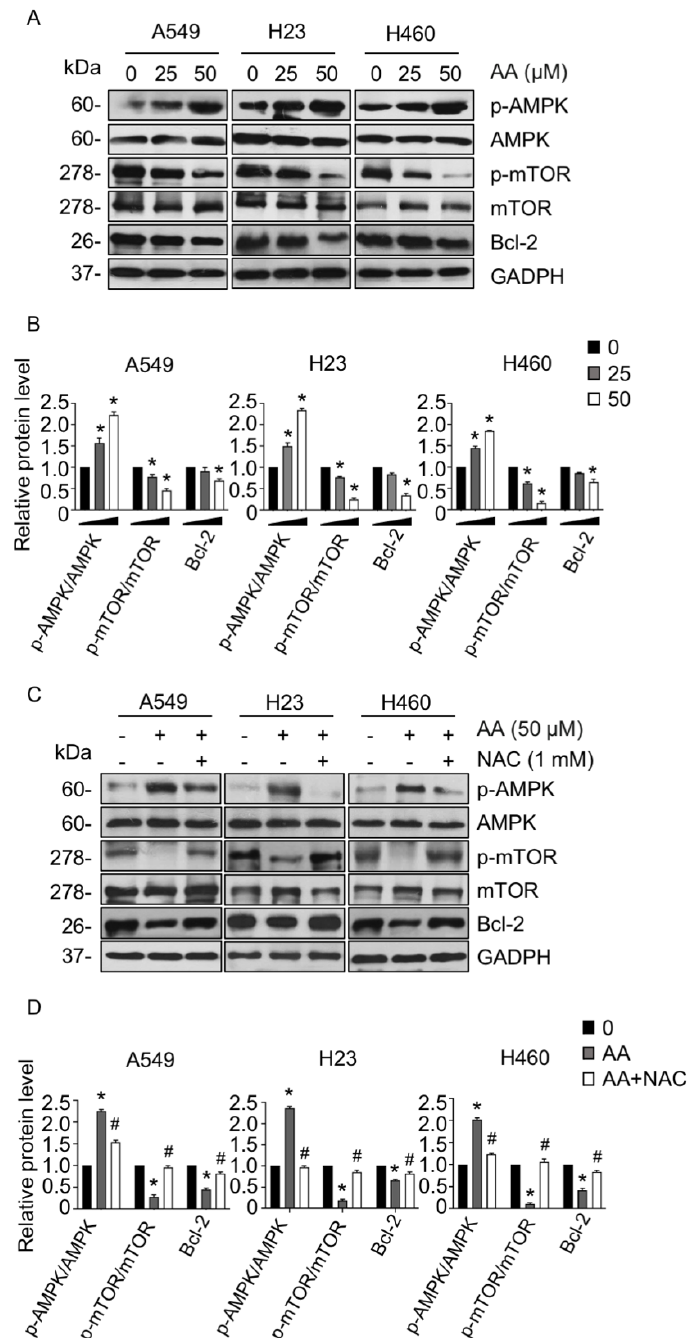
Figure 4. Aspiletrein A (AA) induced apoptosis via the AMPK/mTOR/Bcl-2 signaling in a ROS- dependent mechanism. ( A ) Lung cancer cells were treated with AA (0–50 μM) for 24 h. The level of p-AMPK, AMPK, p-mTOR, mTOR, and Bcl-2 were analyzed via Western blotting. Blots were re-probed with anti-GAPDH to confirm equal loading. ( B ) Protein level was quantified and presented as a relative value to the control. Data are mean ± SEM ( n = 4). * p < 0.05 vs. control cells. ( C ) Lung cancer cells were pretreated with NAC (1 mM) for 30 min in the presence or absence of AA (50 μM) for 24 h. The level of p-AMPK, AMPK, p-mTOR, mTOR, and Bcl-2 were analyzed via Western blotting. Blots were re-probed with anti-GAPDH to confirm equal loading. ( D ) Protein level was quantified and presented as a relative value to that of the control. Data are mean ± SEM ( n = 4). * p < 0.05 vs. control cells, # p < 0.05 vs. AA-treated cells.